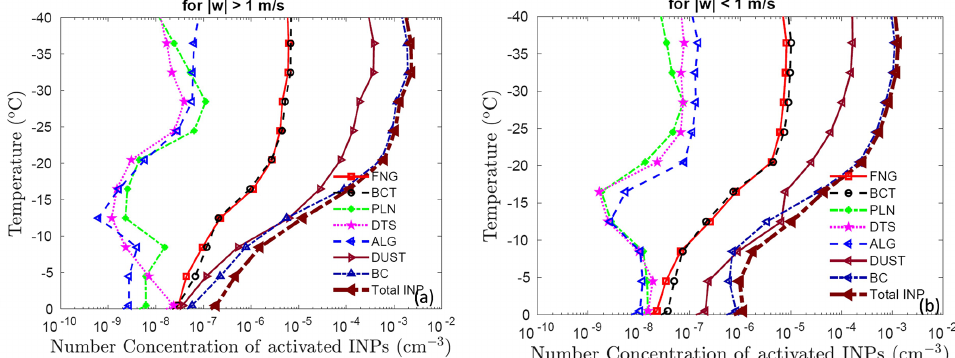
Figure 4. The activated number concentration of INPs from various PBAP groups are shown along with dust (DUST) and black carbon (BC) and total INPs at various temperatures for (a) convective and (b) stratiform regions. All the vertical profiles shown here are averaged for the whole domain.